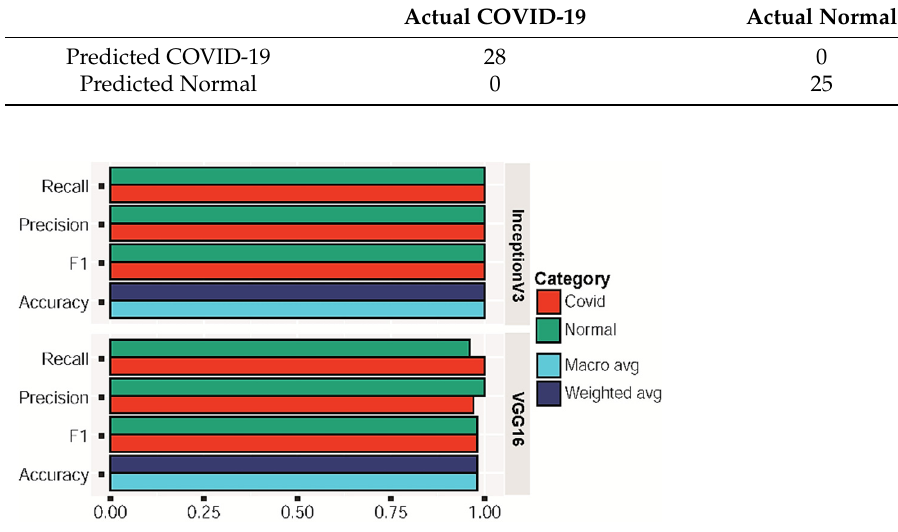
Figure 5. Precision, recall, F score, and accuracy for VGG16 and Inception-v3 on chest